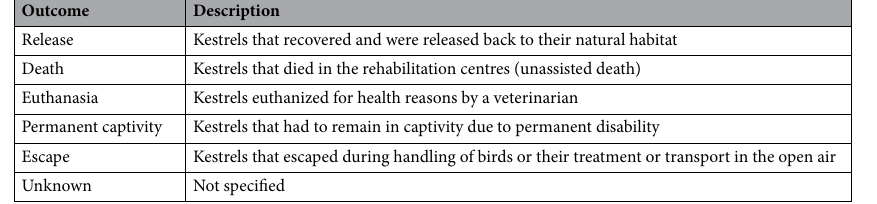
Table 5. Outcomes for common kestrels in the rehabilitation centres in the Czech